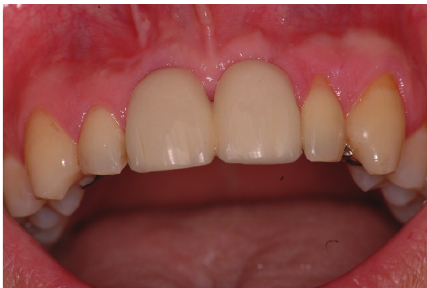
Figure 4: Clinical control at three months. The patient showed remarkable healing of the soft tissues, and the gingiva appeared with an excellent color and texture of the tissue too. It also began to outline the proper and harmonious design of the facial mucosa curvatures, which were conditioned by the interim prosthesis.